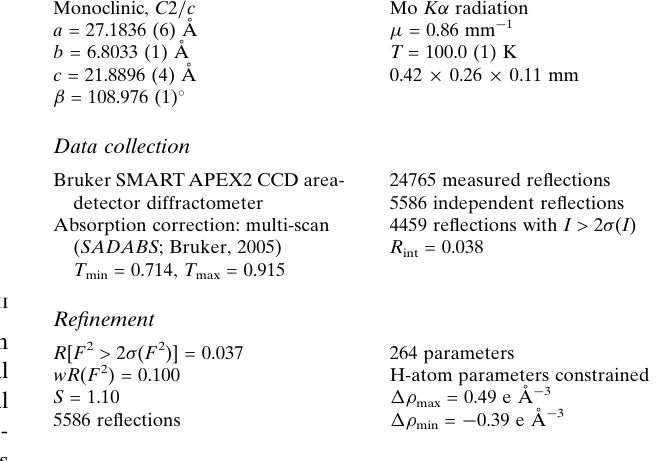
24765 measured reflections 5586 independent reflections 4459 reflections with I > 2 (cid:1) ( I ) R int = 0.038